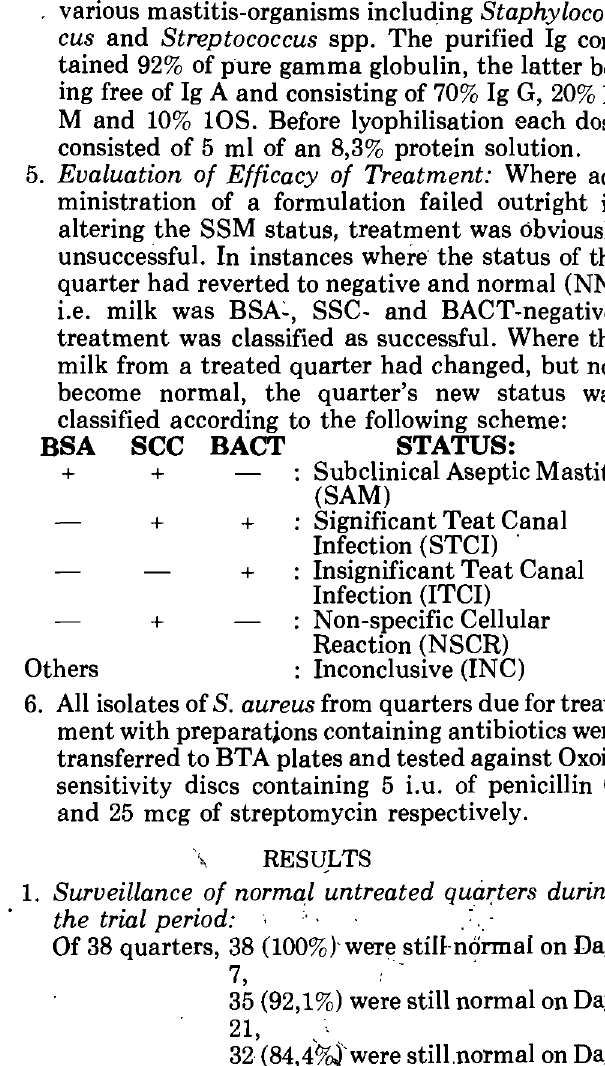
Table 1: PRE- AND POST-TREATMENT STATUS OF SMM POSITIVE QUARTERS AFTER TWO (DAY 21). THREE (DAY 28). AND FOUR WEEKS (DAY 35) USING ONE OF FORMULATIONS